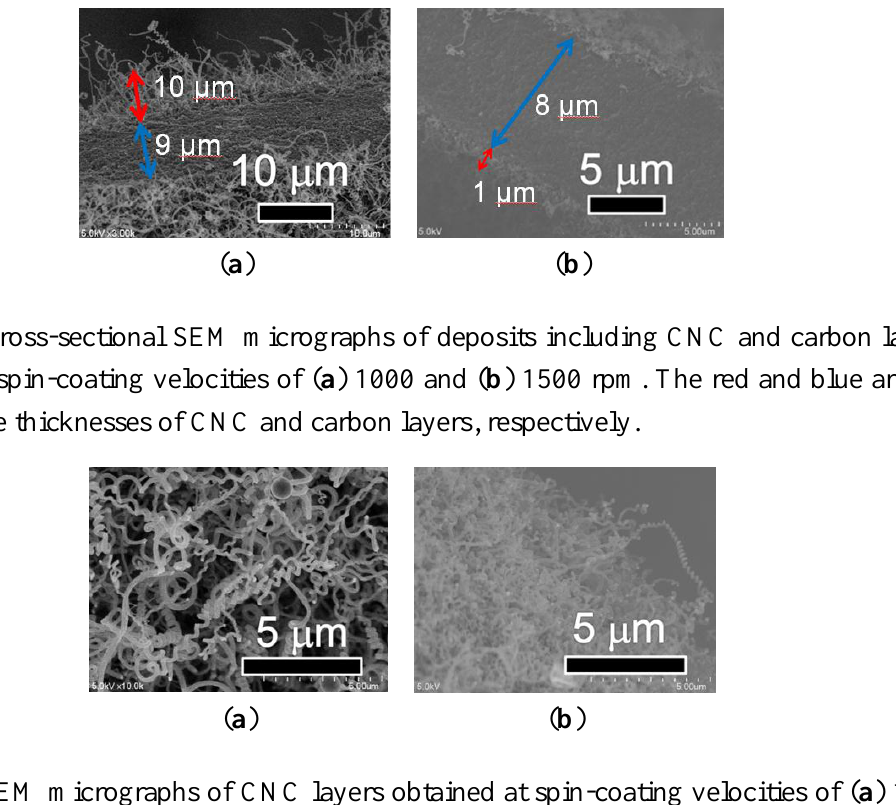
Figure 5. SEM micrographs of CNC layers obtained at spin-coating velocities of ( a ) 1000 and ( b ) 1500